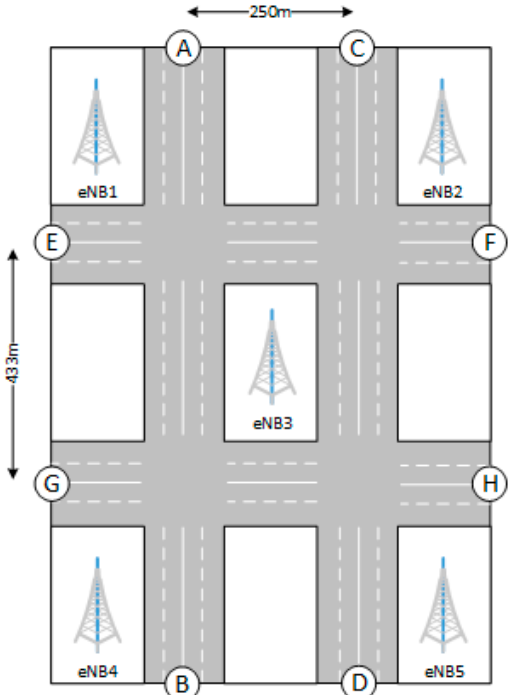
Figure 26. Urban grid scenario.